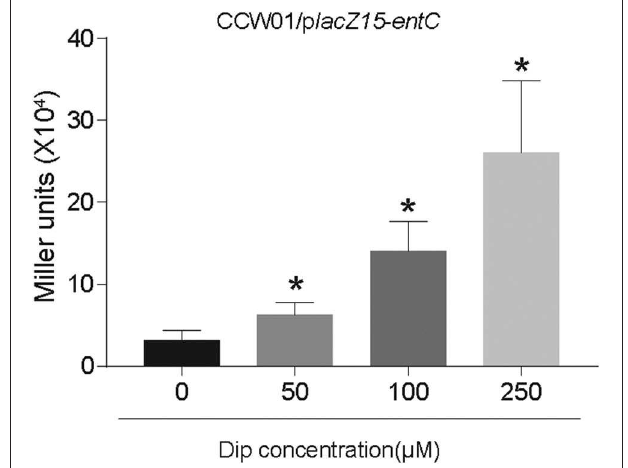
FIGURE 2 | Iron starvation enhanced the activity of the entC promoter. The putative promoter region of entC was cloned into the p lacZ 15 plasmid and then introduced into CCW01 to measure β -galactosidase activity (Miller units) in increasing amounts of Dip. * P < 0.05, compared with the 0 µ M Dip